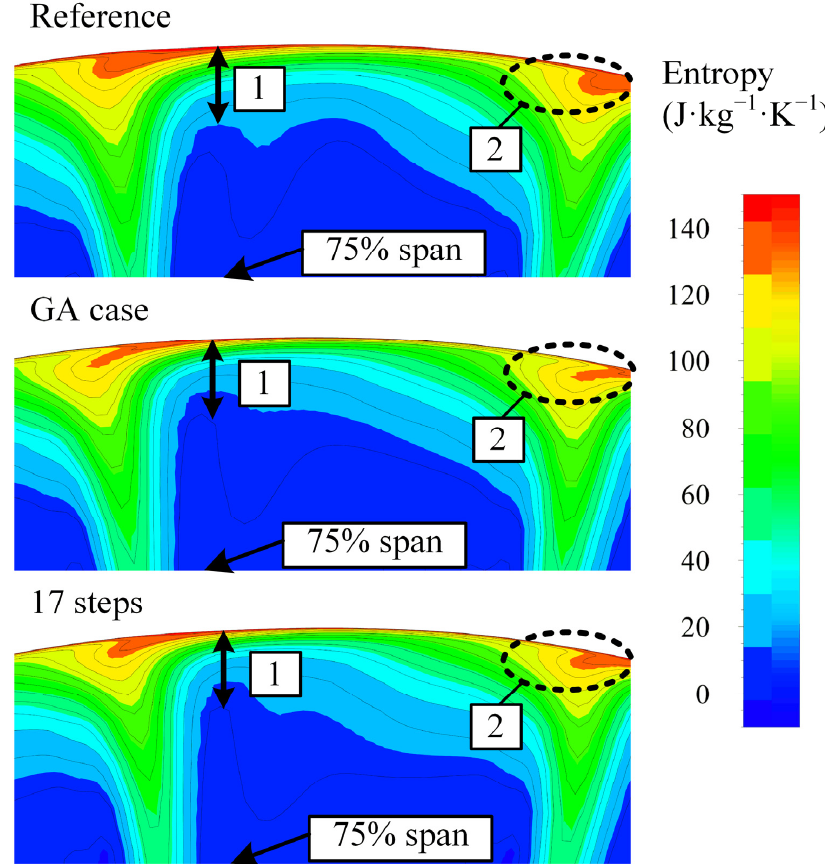
Figure 23. Entropy distribution of the meridional velocity at 50% and 80% of the axial length.